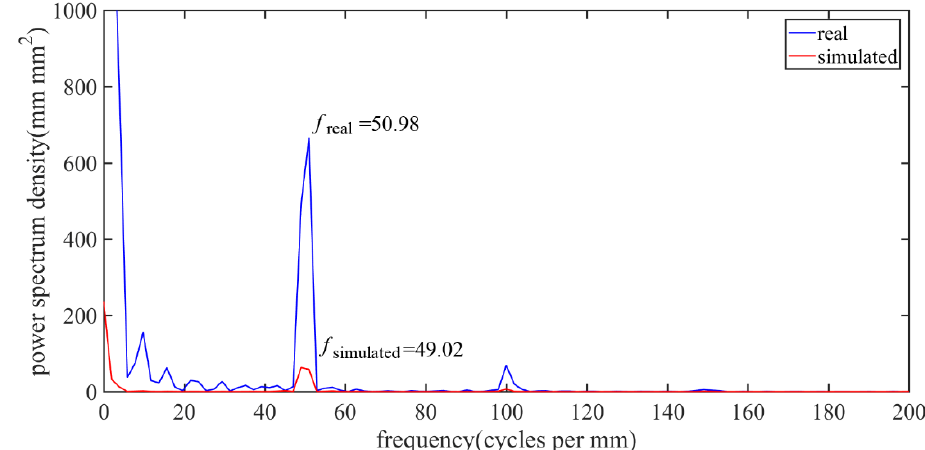
Figure 12. The calculated power spectrum density of the cross-sectional profile height between the simulated and the machined surface.